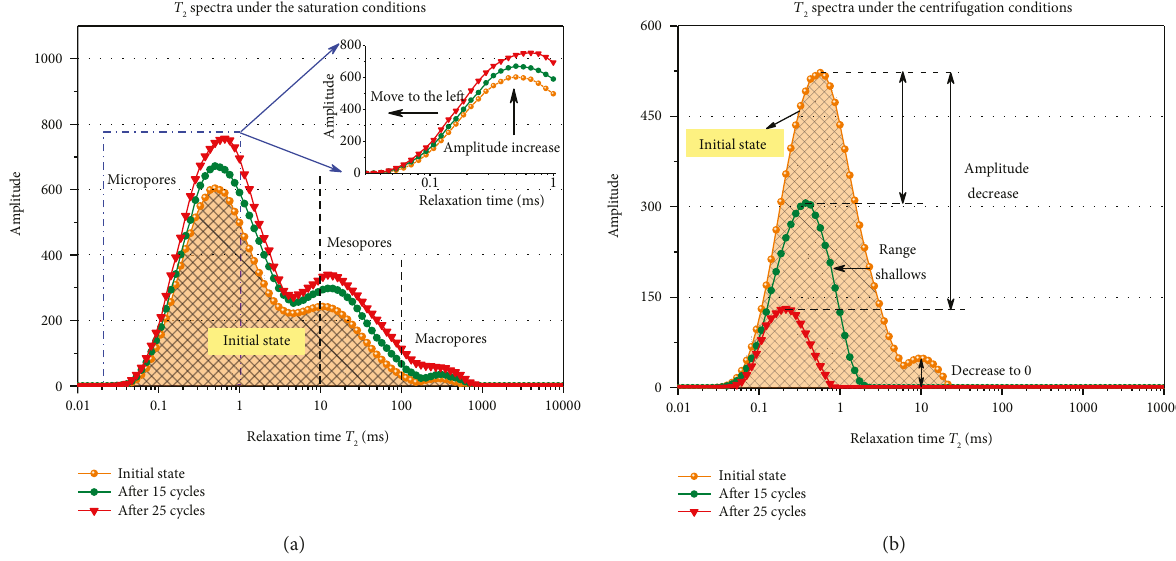
Figure 4: T spectral curves of core sx-1 under the saturation and centrifugation 2